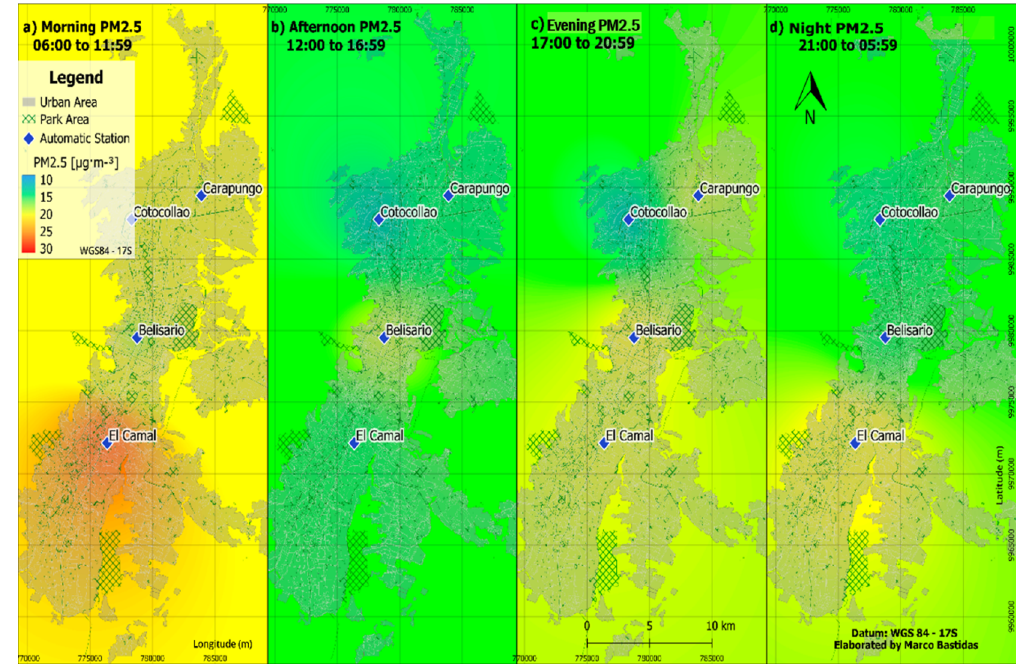
Figure 2. Average (2017–2018) PM 2.5 concentrations in Quito for: ( a ) morning rush hours (06:00–11:59), ( b ) afternoon (12:00–16:59), ( c ) evening rush hours (17:00–20:59), and ( d ) night (21:00–05:59), as shown by the IDW interpolation among monitoring stations.